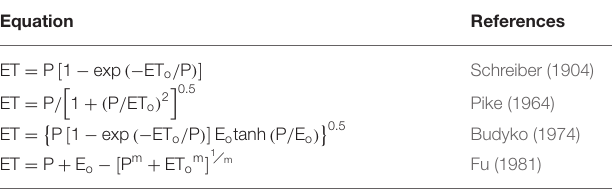
TABLE 1 | Equations used to estimate actual annual